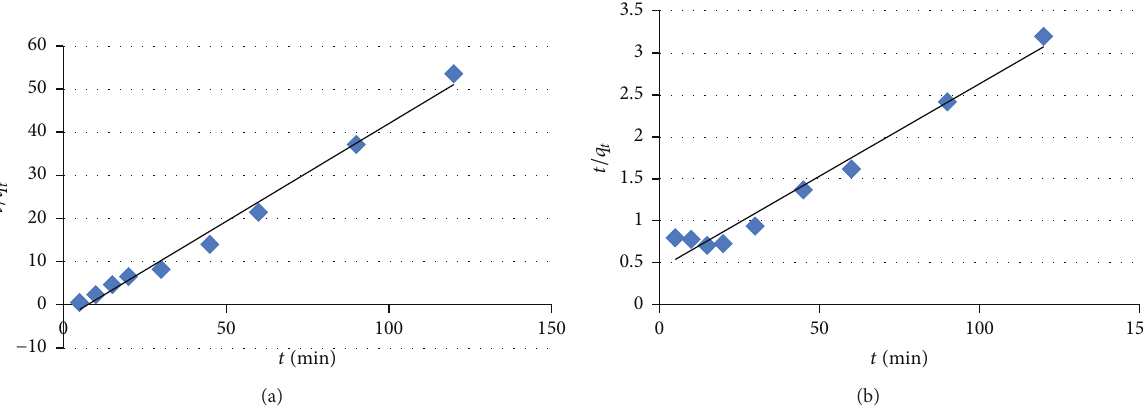
Figure 8: Pseudosecond-order kinetics model for (a) Fe/Pt bimetallic nanoparticles and (b) resins at 25 ± 1 ∘ C.